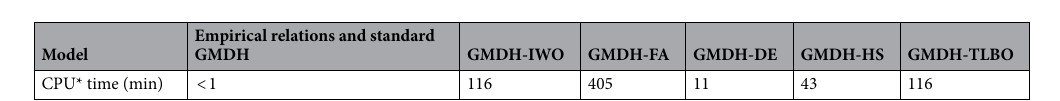
Table 6. The CPU time for 300 epochs of the applied GMDH models. *Core i7; RAM: 8 GB.